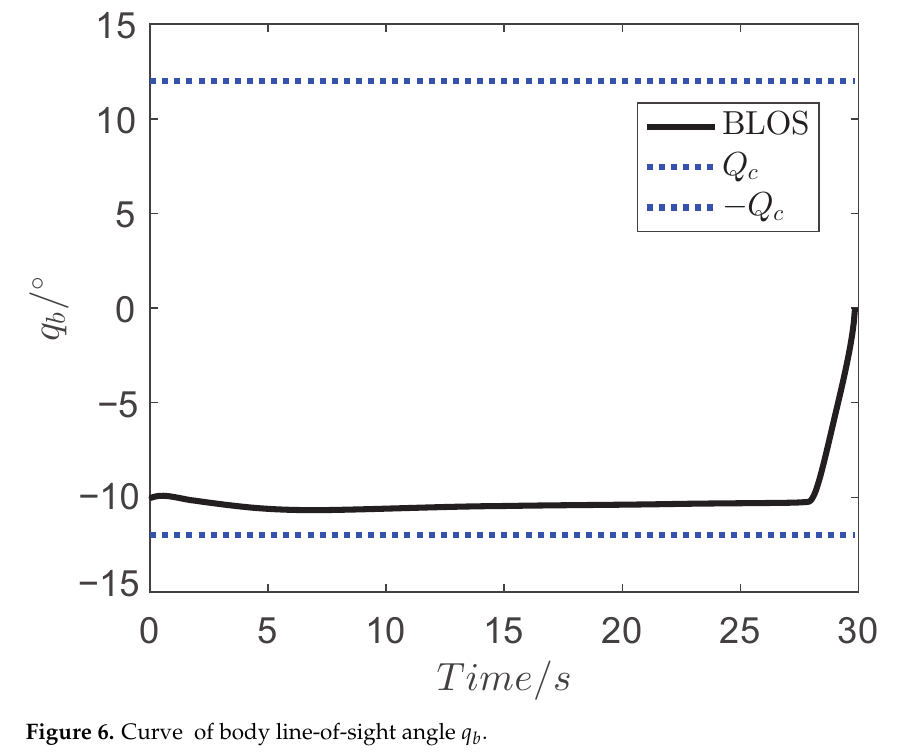
Figure 6. Curve of body line-of-sight angle q b .